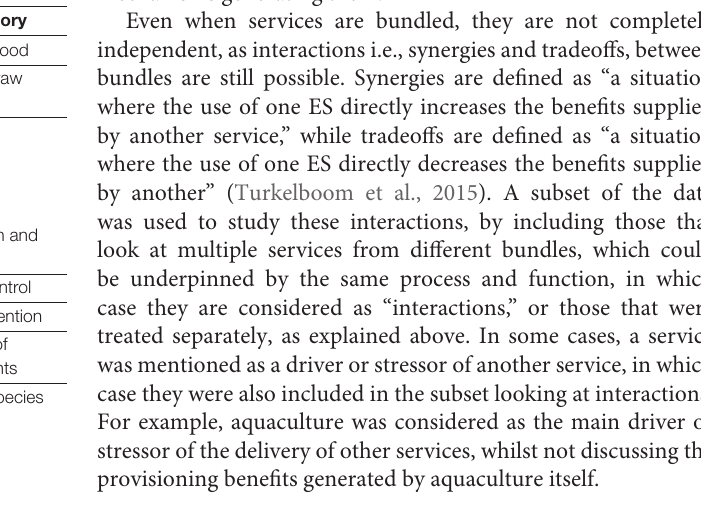
TABLE 1 | Overview of the ecosystem services found in the reviewed literature as function of service